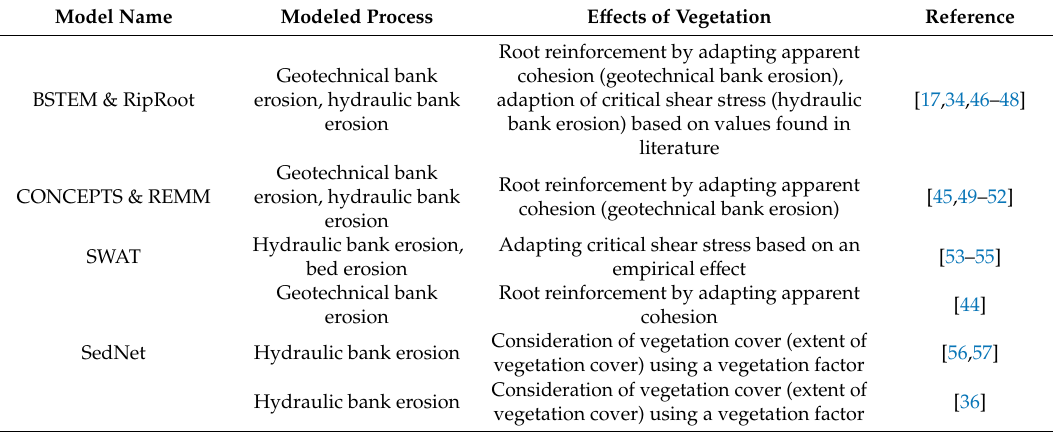
Table 1. Examples of existing bank erosion models that consider the stabilizing e ff ects of